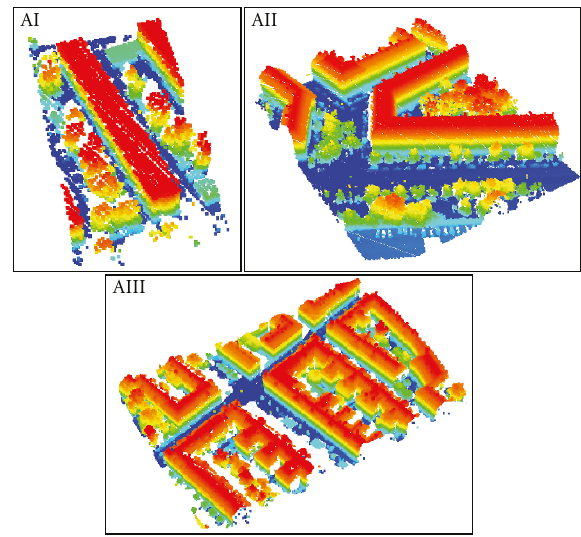
Figure 7: The three randomly chosen landmarks